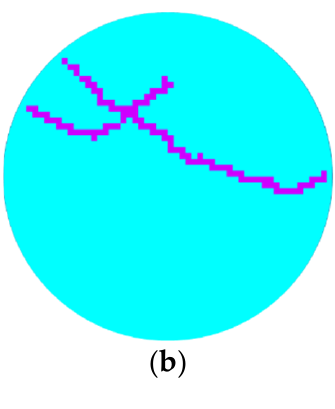
Figure 2. ( a ) Open defects, ( b ) short defects, ( c ) line contamination, and ( d ) bite defects in a patterned wafer defect map.